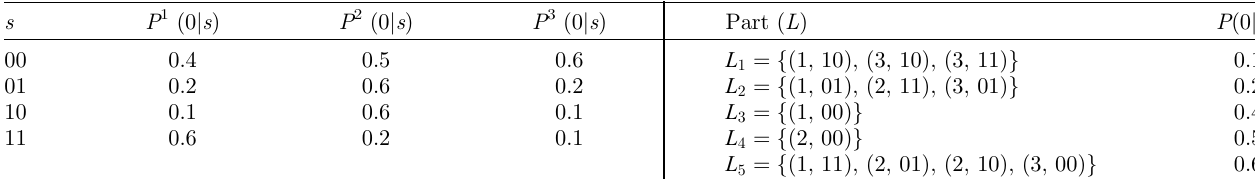
Table 1. Left : conditional probabilities for the processes 1, 2 and 3. Right : parts of partition L of M